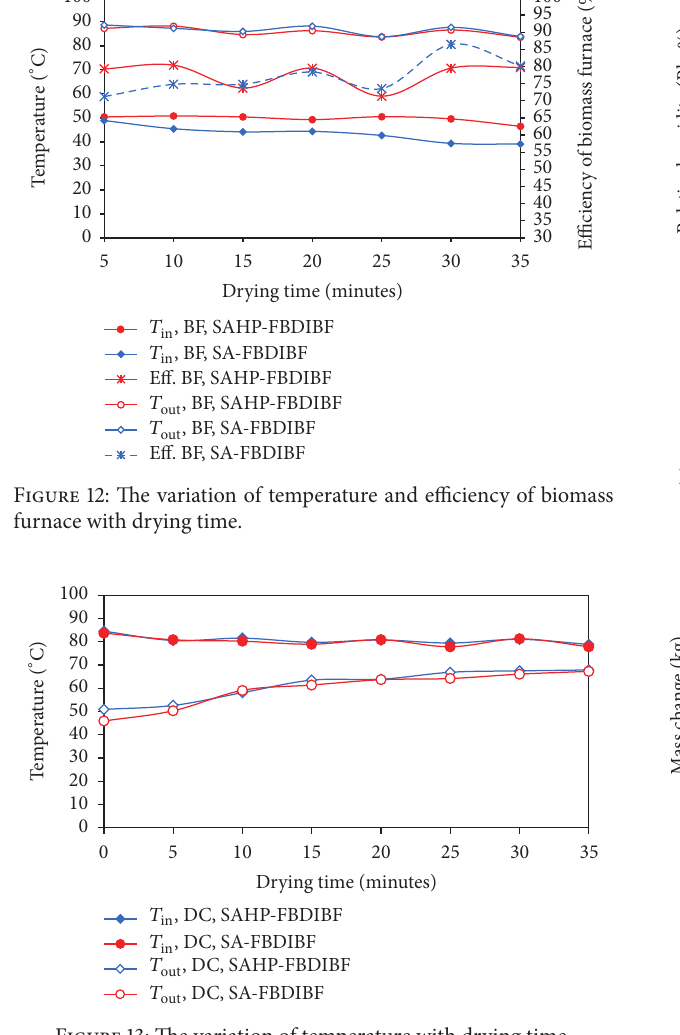
Figure 13: The variation of temperature with drying time.